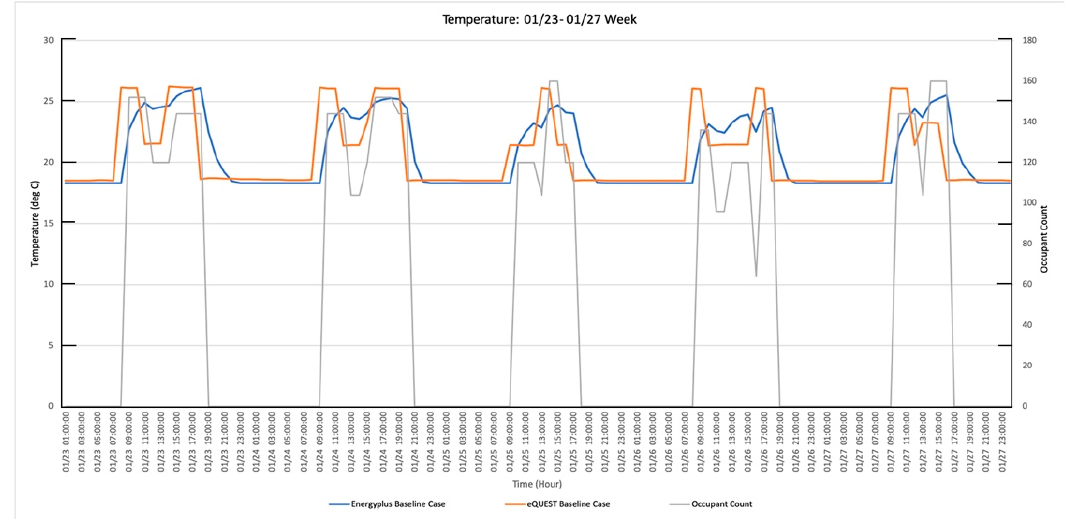
Figure 6. Temperature throughout a week, referencing occupants count.